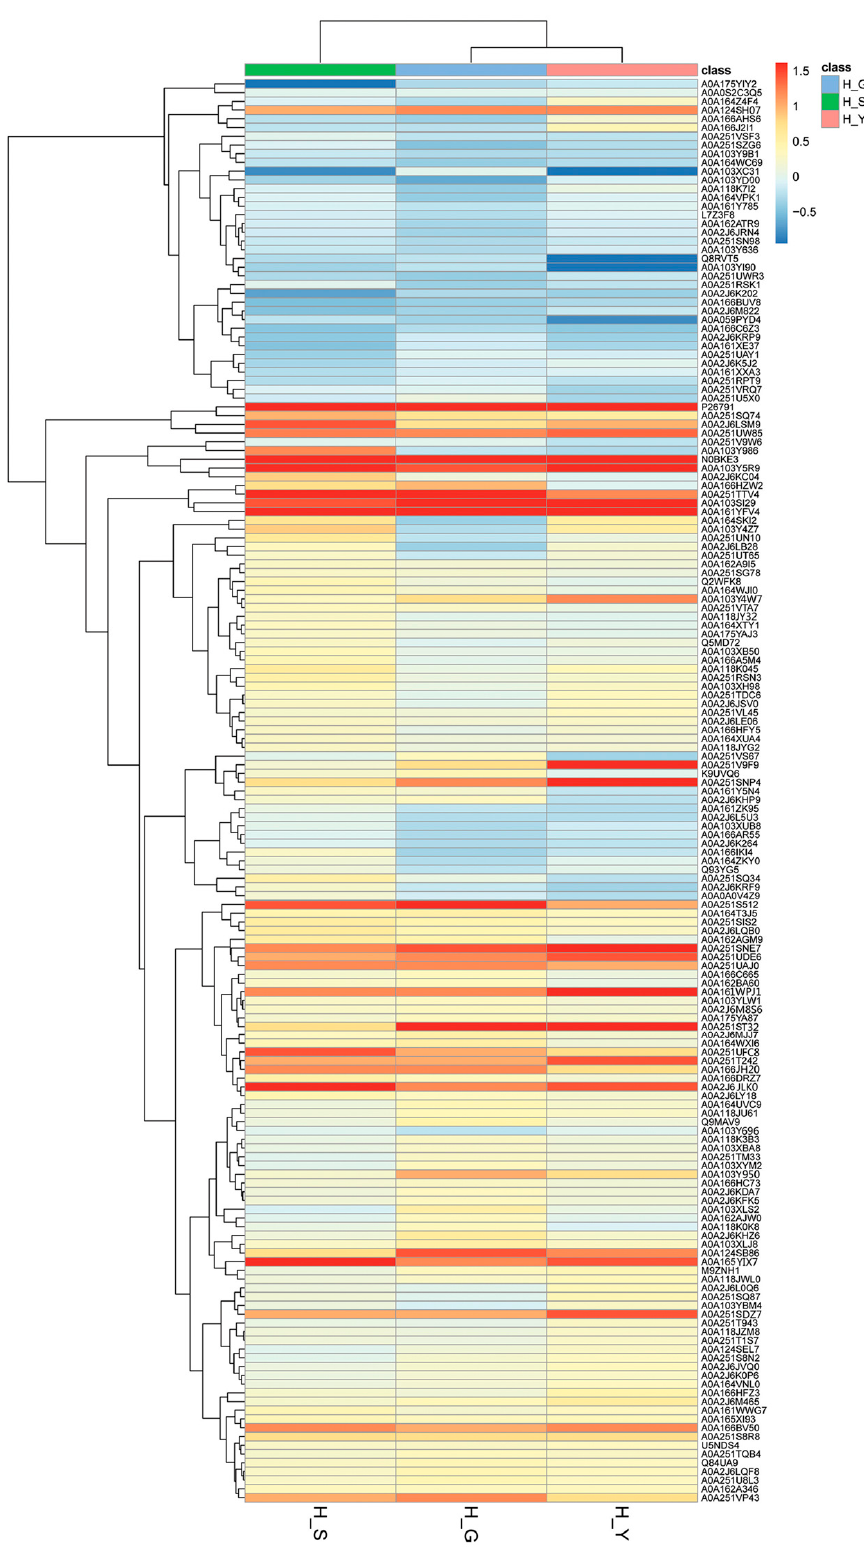
Figure 4. Thermal maps of di ff erences in proteins expression. One grid in a thermal map stands for one protein, and the color for the magnitude. A deeper color means larger magnitude, while red and blue mean the protein expression is upregulated and downregulated, respectively. The left and right sides represent the H vs. S, H vs. G, and H vs. Y groups, respectively. One row means the expression level of each protein in a group, while the column means the di ff erences in proteins